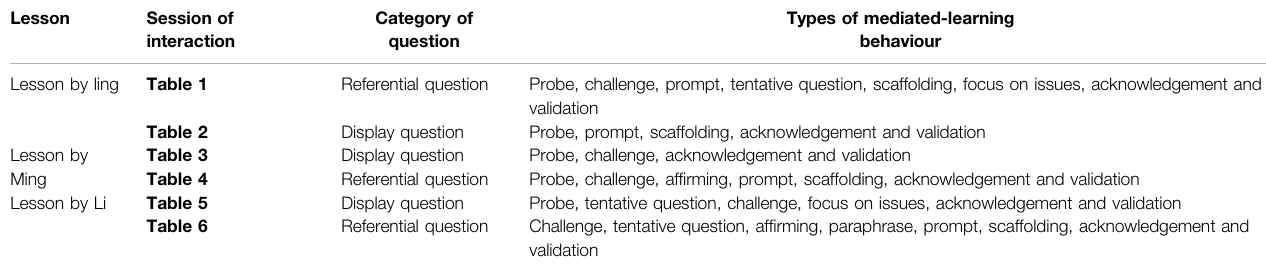
Table 5 challenged student to provide reasons and opinions